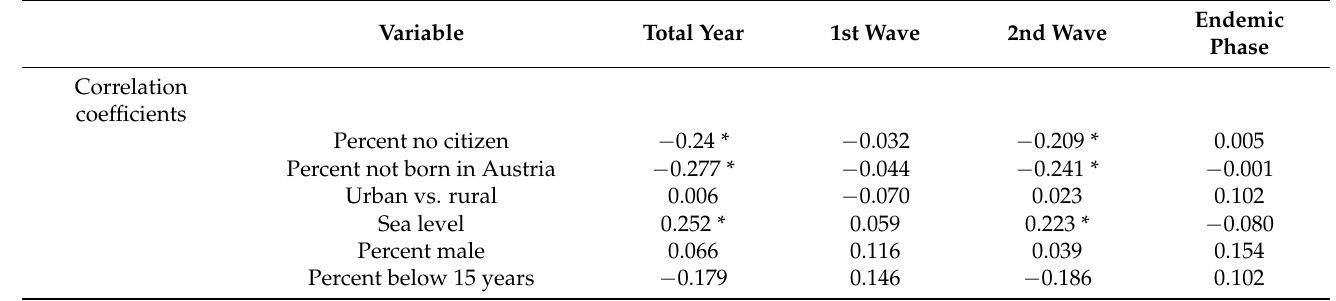
Table A2. Correlation coefficients between cumulative deaths and the independent variable ln (deaths +